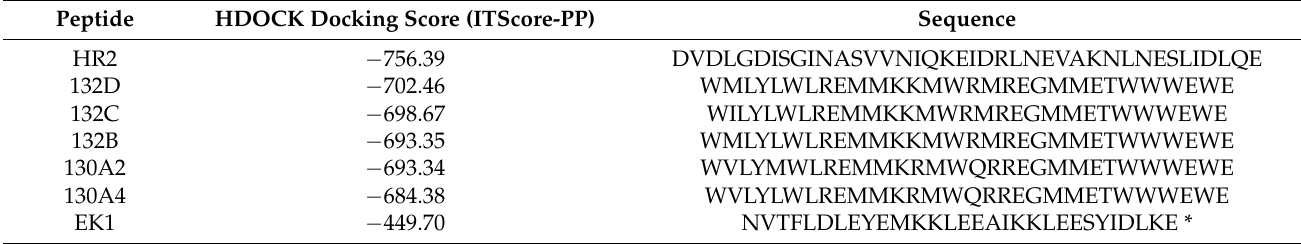
Peptide Table 1. HDOCK score and sequences of HR2, EK1, and top five peptide inhibitors to SARS-CoV-2-WT HR1 domain. Peptide